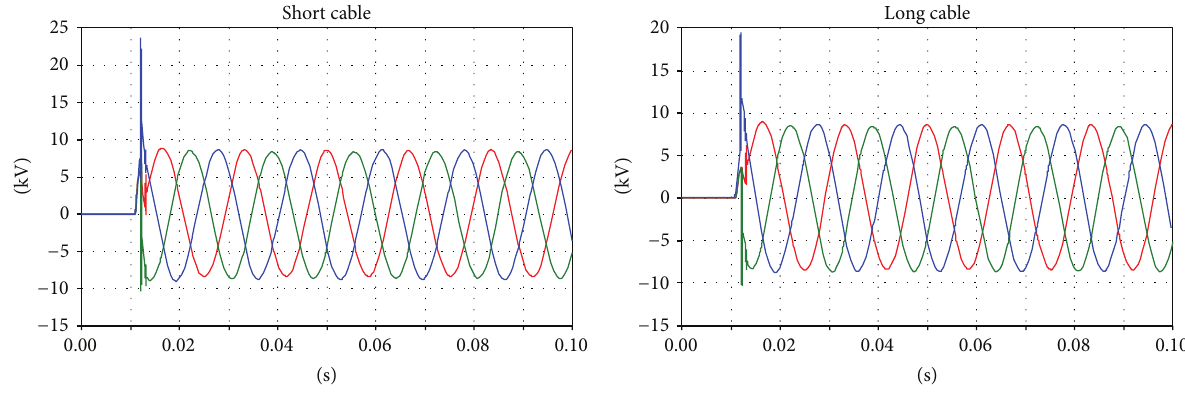
Figure 13: The primary side voltages during the